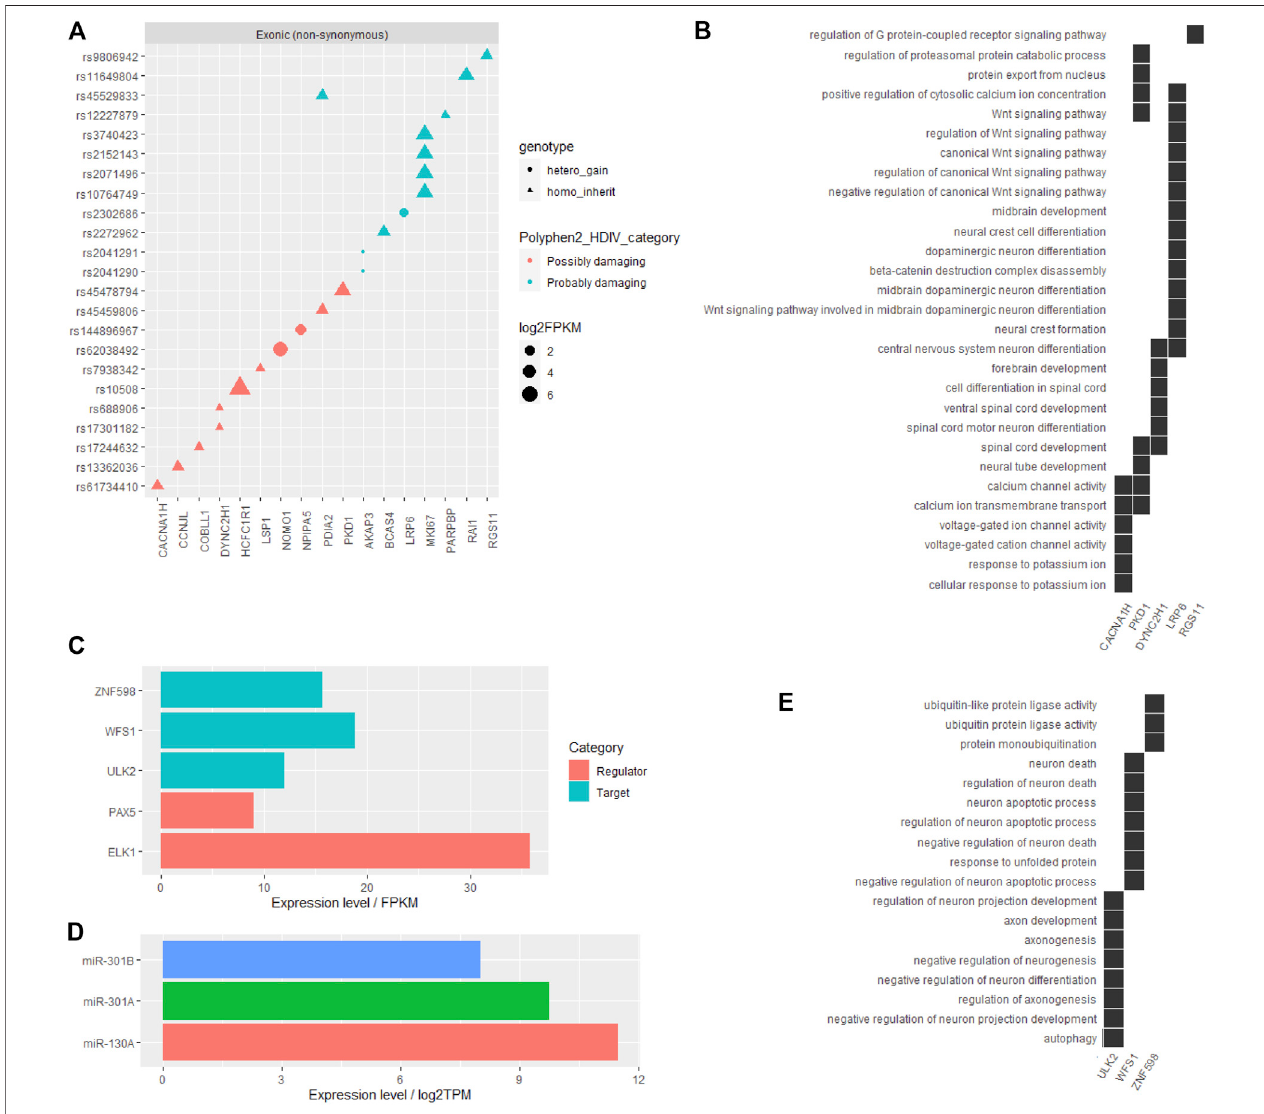
FIGURE 2| Functional annotation on the fi ltered SNVs in the reported ADHD-susceptible regions. (A) A dot plot showing the information of fi ltered SNVs in coding regions and their corresponding genes. SNV genotype, in fl uence on protein functions, and gene expression level were marked by dot shape, color, and size, respectively. (B) Aheatplotshowingthedistributionofcertaingenesonneuron-relatedfunctionspotentiallyinvolvedinADHD. (C) Barplotshowingtheexpressionlevels ofcertaingenes, including the genescorrespondingtofunctionalannotated SNVs in thepromoter or 3 ′ -UTRand their relative regulators inhuman braintissue. (D) Bar plot showing the expression levels of miRNAs that targeted the site affected by the identi fi ed SNV. (E) A heat plot showing the distribution of certain genes corresponding to SNVs in the promoter or 3 ′ -UTR on neuron-related functions.